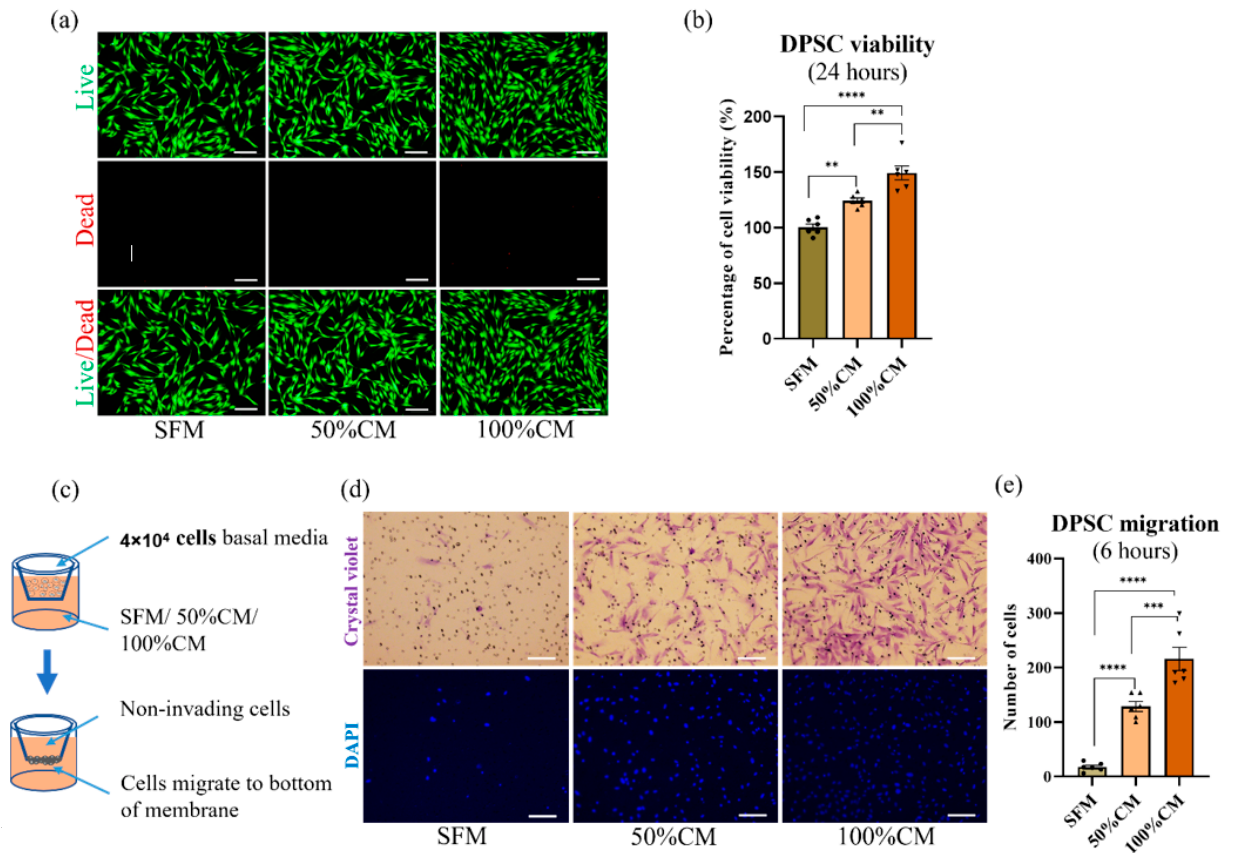
Figure 2. Effect of stem cells isolated from human pulp of exfoliated deciduous tooth-derived conditioned media (CM) on dental pulp stem cells (DPSCs) regarding proliferation and migration. ( a ) Presentative live and dead images of SHED 24 h after treatment with 100% CM versus 50% CM and SFM. Scale bar represents 200 µ m. ( b ) The effect of SHED CM after treatment for 24 h on the proliferation of SHED was quantified by CCK-8 assay. n = 6. ( c ) Schematic of migration assays. A total of 4 × 10 4 cells in 100 µ L were seeded in the upper compartment, while the lower compartment contained 350 µ L 100% CM, 50% CM or SFM. ( d ) Representative images of migrated SHED in the lower compartment of membrane after 6 h of treatment. ( e ) Cells counted in the lower compartment in 6 random fields. All data are represented as the mean ± standard deviation